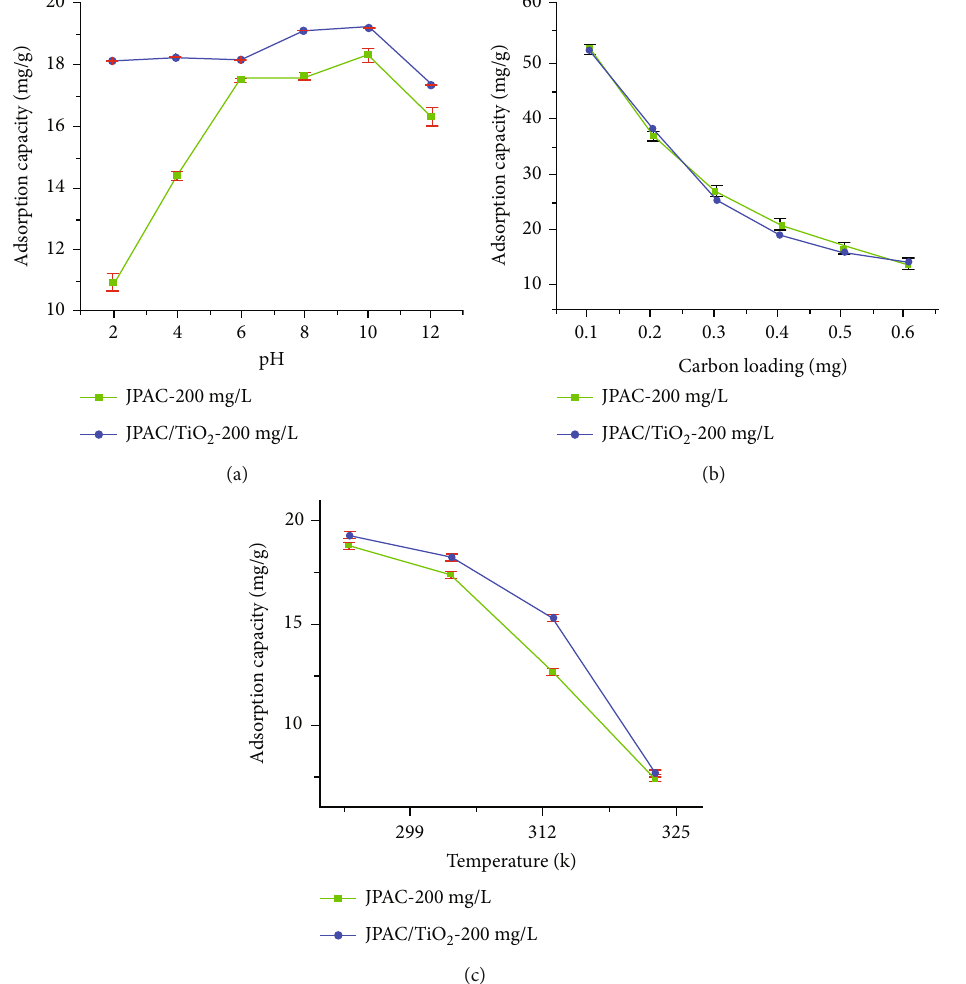
Figure 9: E ff ect of (a) pH, (b) carbon loading, and (c) temperature of Red 2BN dye on JPAC and JPAC/TiO ( adsorbent dose = 0 : 5 g, Ci = 200 mg/L, pH = 6 : 5 (solution pH), T = 303 K, and contacttime = 4